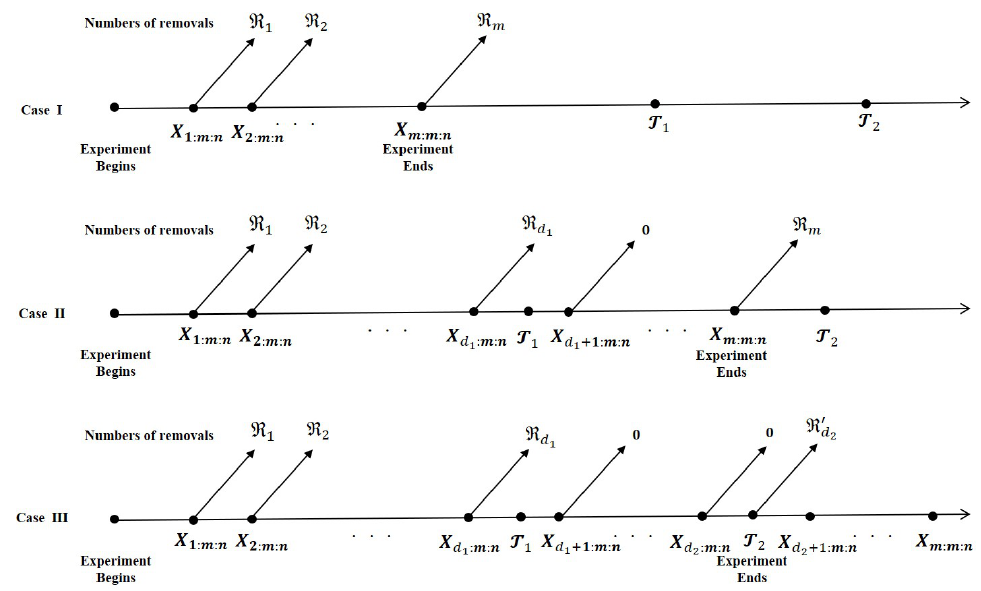
Figure 1. A schematic representation of GAPHC